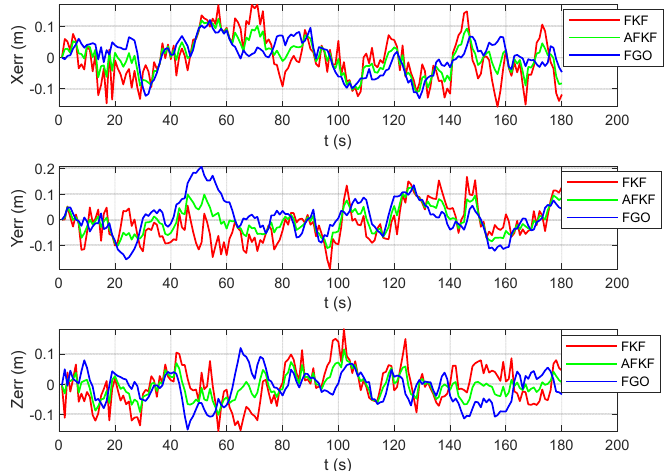
Figure 14. Comparison of position errors of different algorithms in MH_01_easy scene.